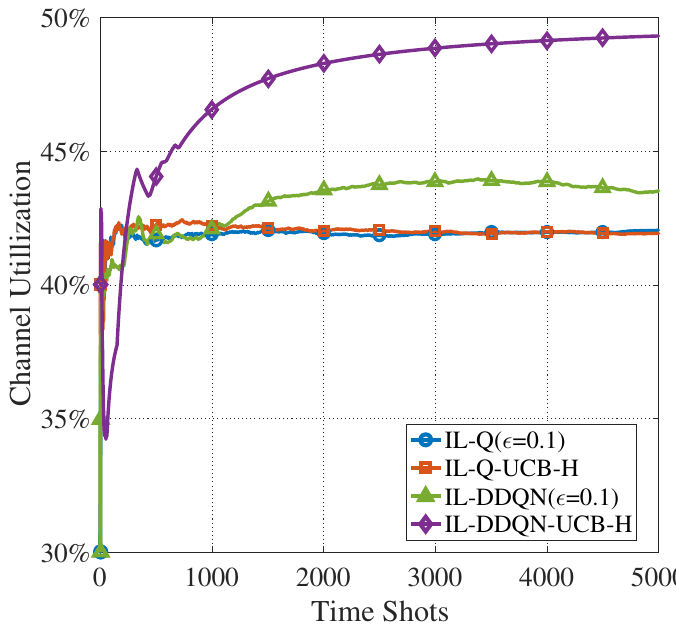
Figure 9. Evolution of the channel utilization of four algorithms ( N = 10, M =